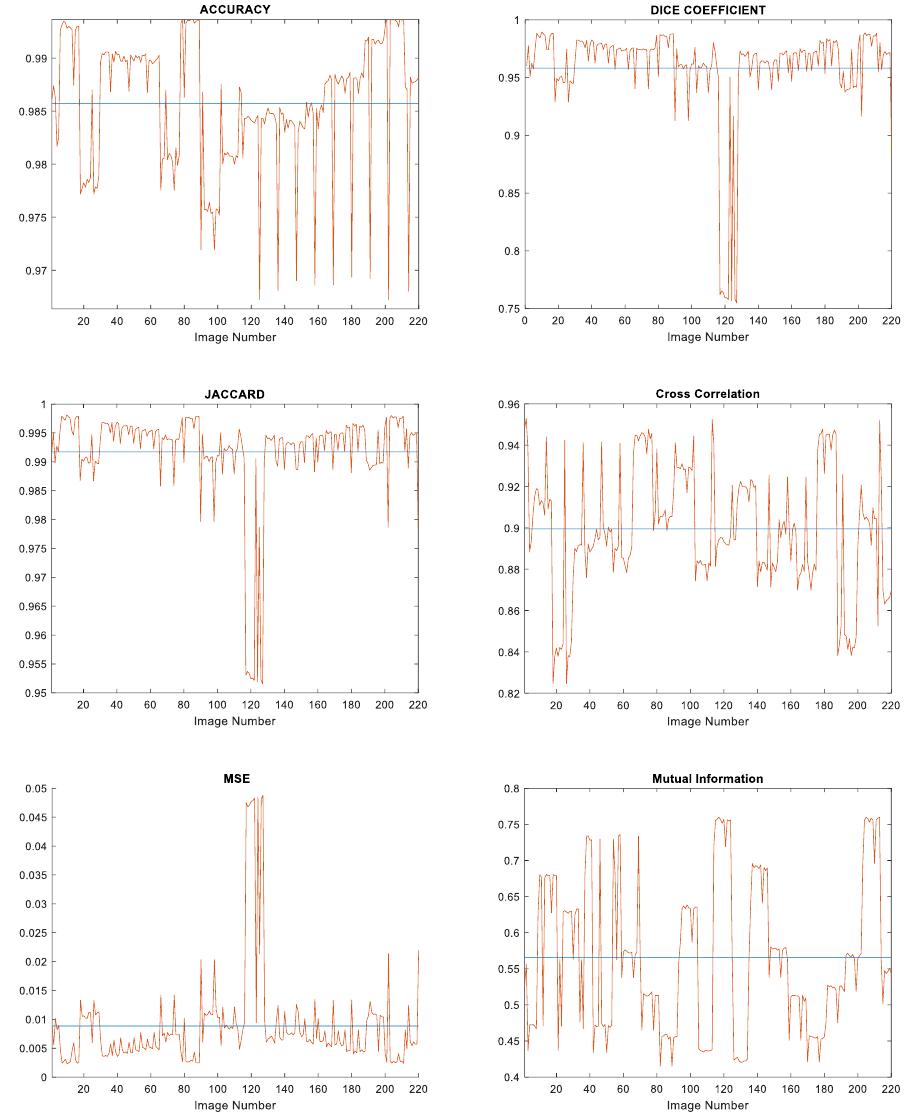
Fig. 10. Performance parameter and similarity index for data